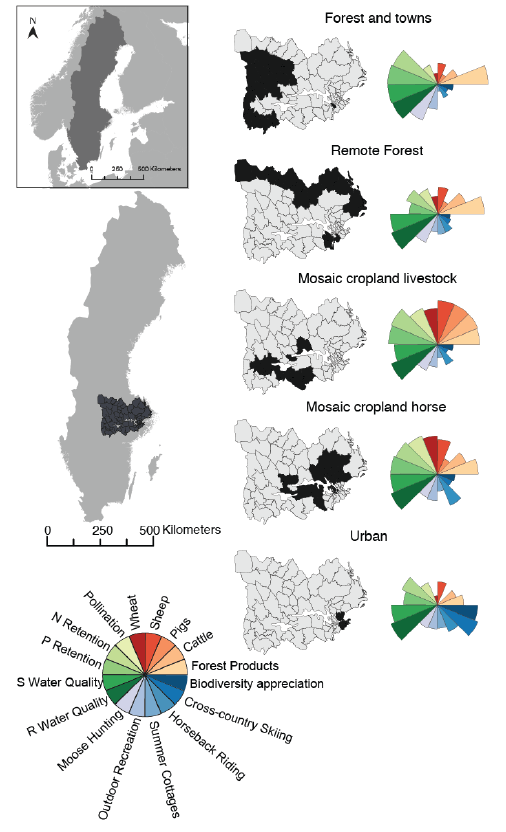
Fig. 1 . Bundles of ecosystem services in the Norrström drainage basin (adapted from Queiroz et al. 2015). Each ecosystem service bundle is represented by a flower diagram, in which the area of each wedge represents the quantity of an ecosystem service. The names of the bundles are descriptive of the social- ecological context and all municipalities belonging to a particular bundle are